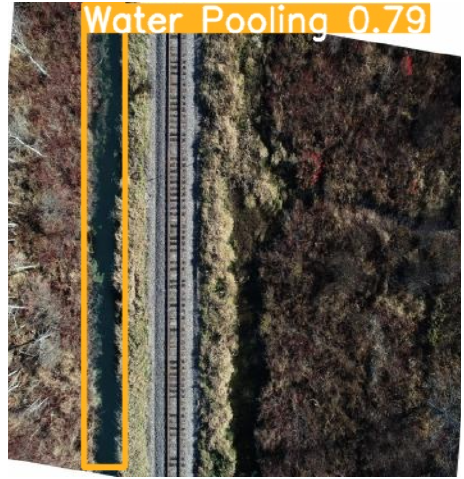
Figure 22. Positive water pooling